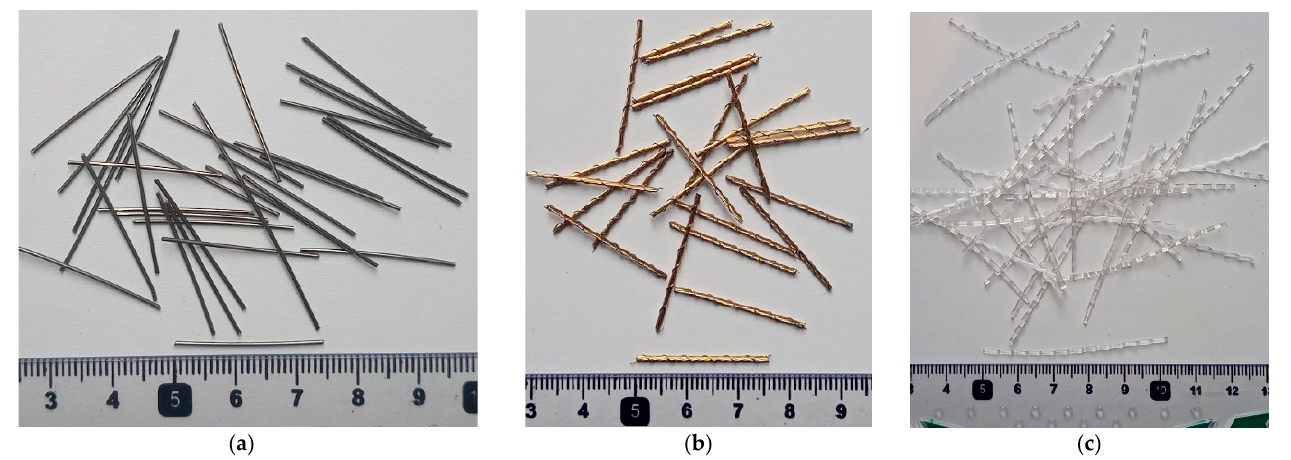
Figure 2. Fibers used: ( a ) steel fibers, ( b ) bundled steel fibers, ( c ) PP fibers.